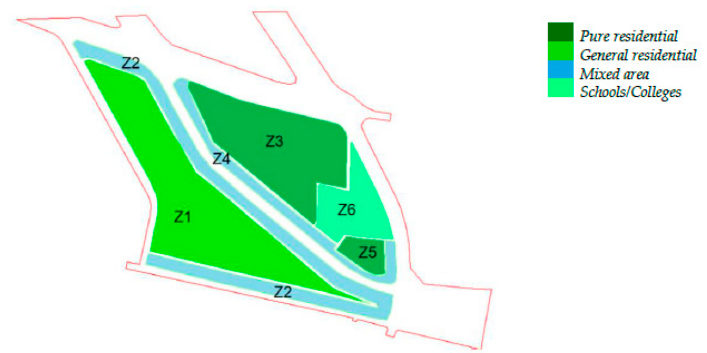
Figure 2. Current planning zones in Al-Fayha District.